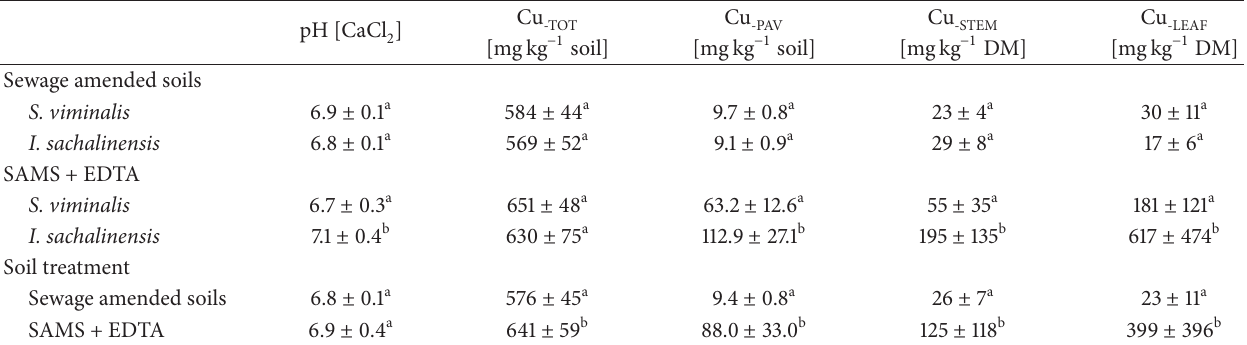
Table 3: Soil pH, total soil Cu (Cu S. viminalis and I. sachalinensis grown on sewage amended soils (SAMS) and SAMS treated with ethylenediaminetetraacetic acid (SAMS +